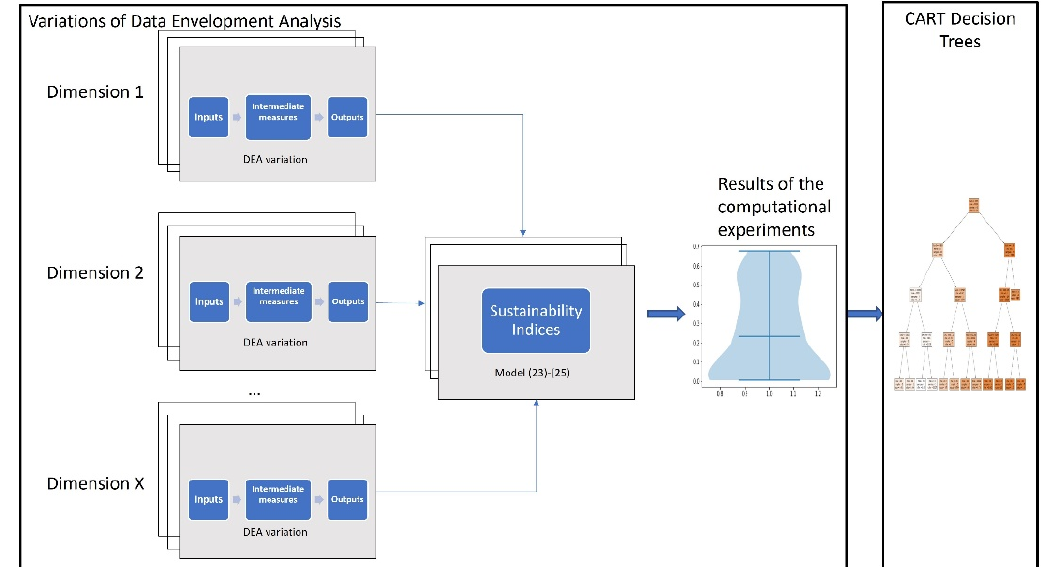
Figure 3. Exploratory, multi-dimensional data envelopment analysis.